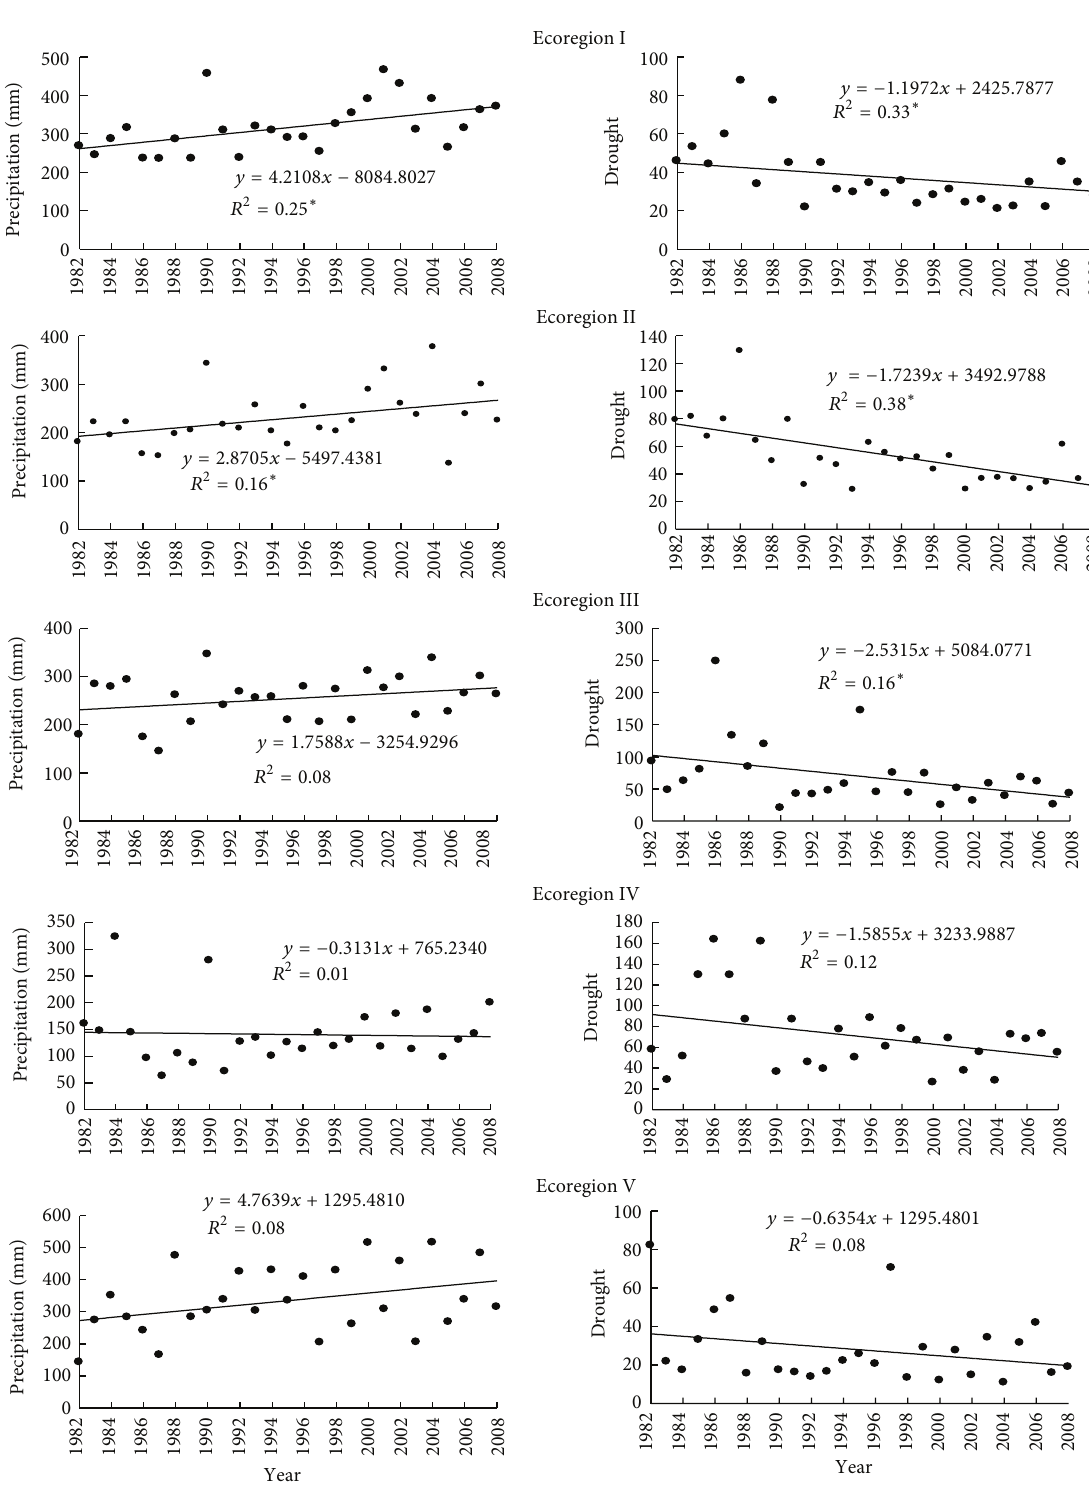
Figure 4: Linear trend of the annual drought episodes and precipitation amounts during fire season for five ecoregions in Yunnan province from 1982 to 2008; the dependent variable is the year and the independent variable is precipitation or drought index value (Formula 2); ∗ denotes significance at the 0.005 level; the significance levels was adjusted by Bonferroni test